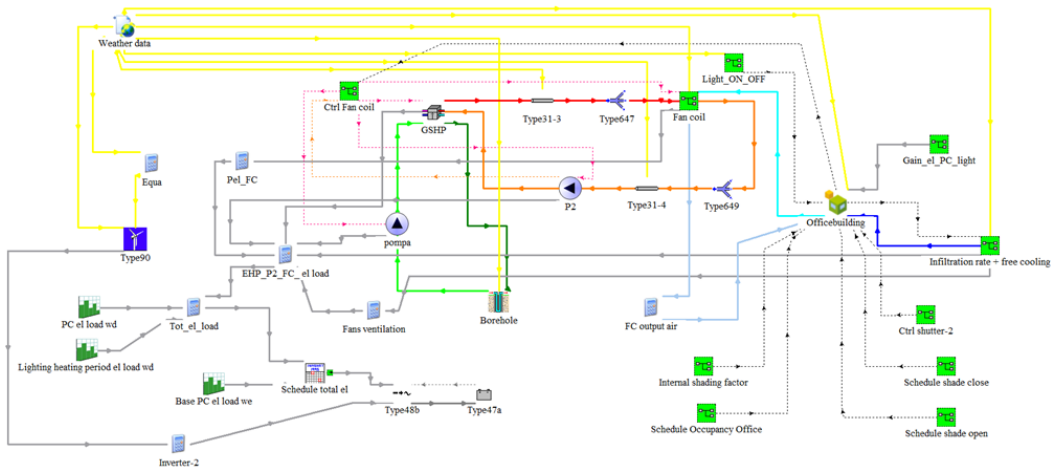
Figure 4. TRNSYS project scheme.